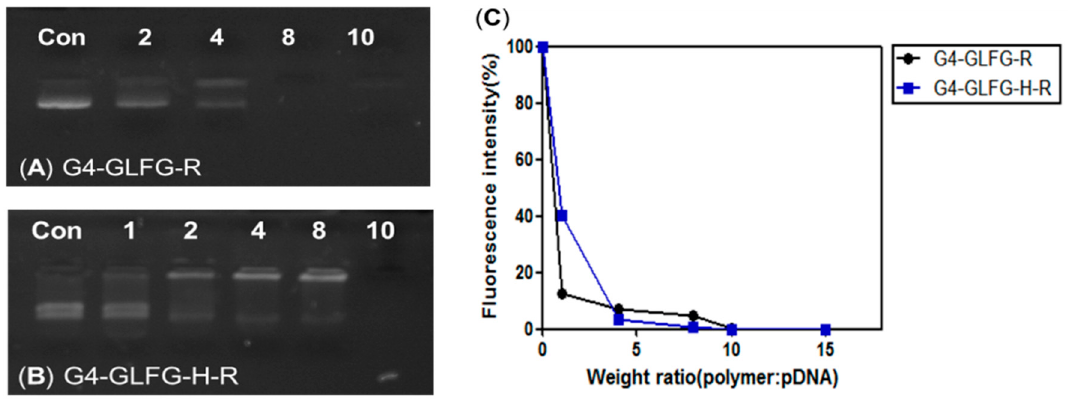
Figure 4. ( A , B ) Agarose gel retardation and ( C ) PicoGreen reagent assay of polyplexes.